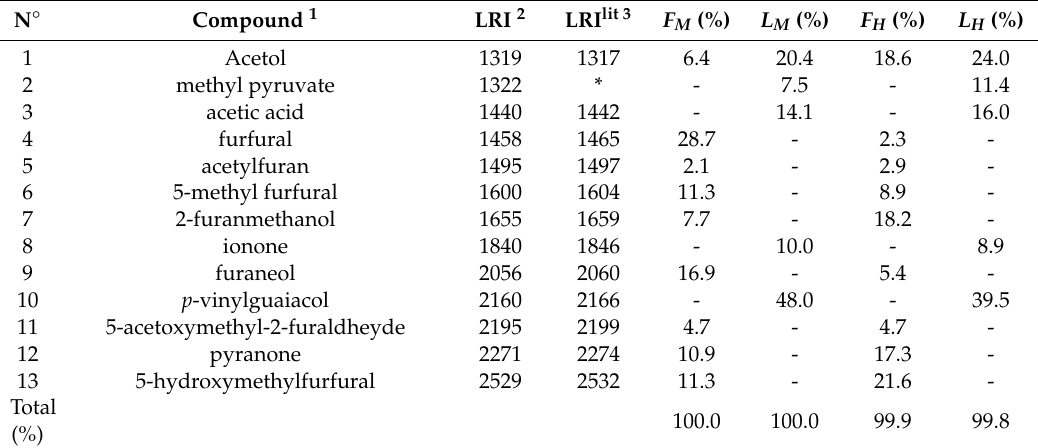
Table 4. Chemical composition (%) of E. angustifolia extracts. N ◦ Compound